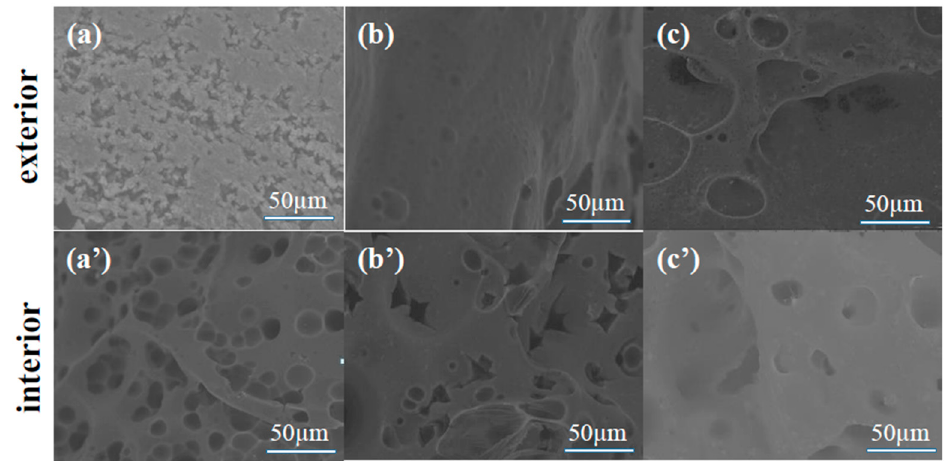
Figure 10. SEM images of the char residues of EP ( a , a’ ), EP / NH 2 -MIL-101(Al) ( b , b’ ), and EP / IL@NH 2 -MIL-101(Al) ( c , c’ ).